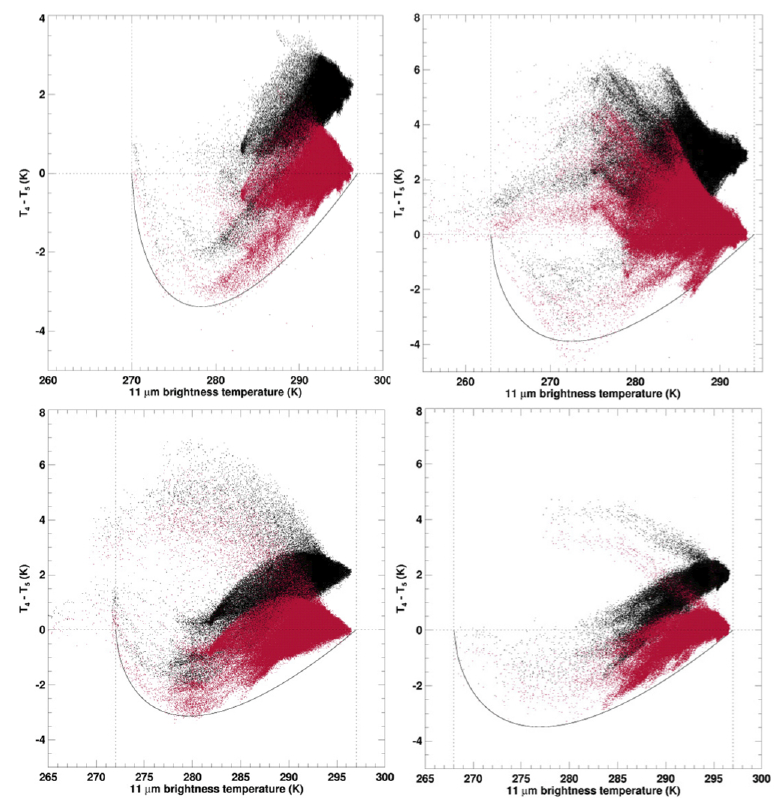
Figure 5. Temperature difference distributions without (black dots) and with (red dots) a water vapour correction for four different volcanic clouds using AVHRR data. T 4 and T 5 are AVHRR channel 4 (11 µ m) and 5 (12 µ m) brightness temperatures and correspond to T 1 and T 2 nomenclature used